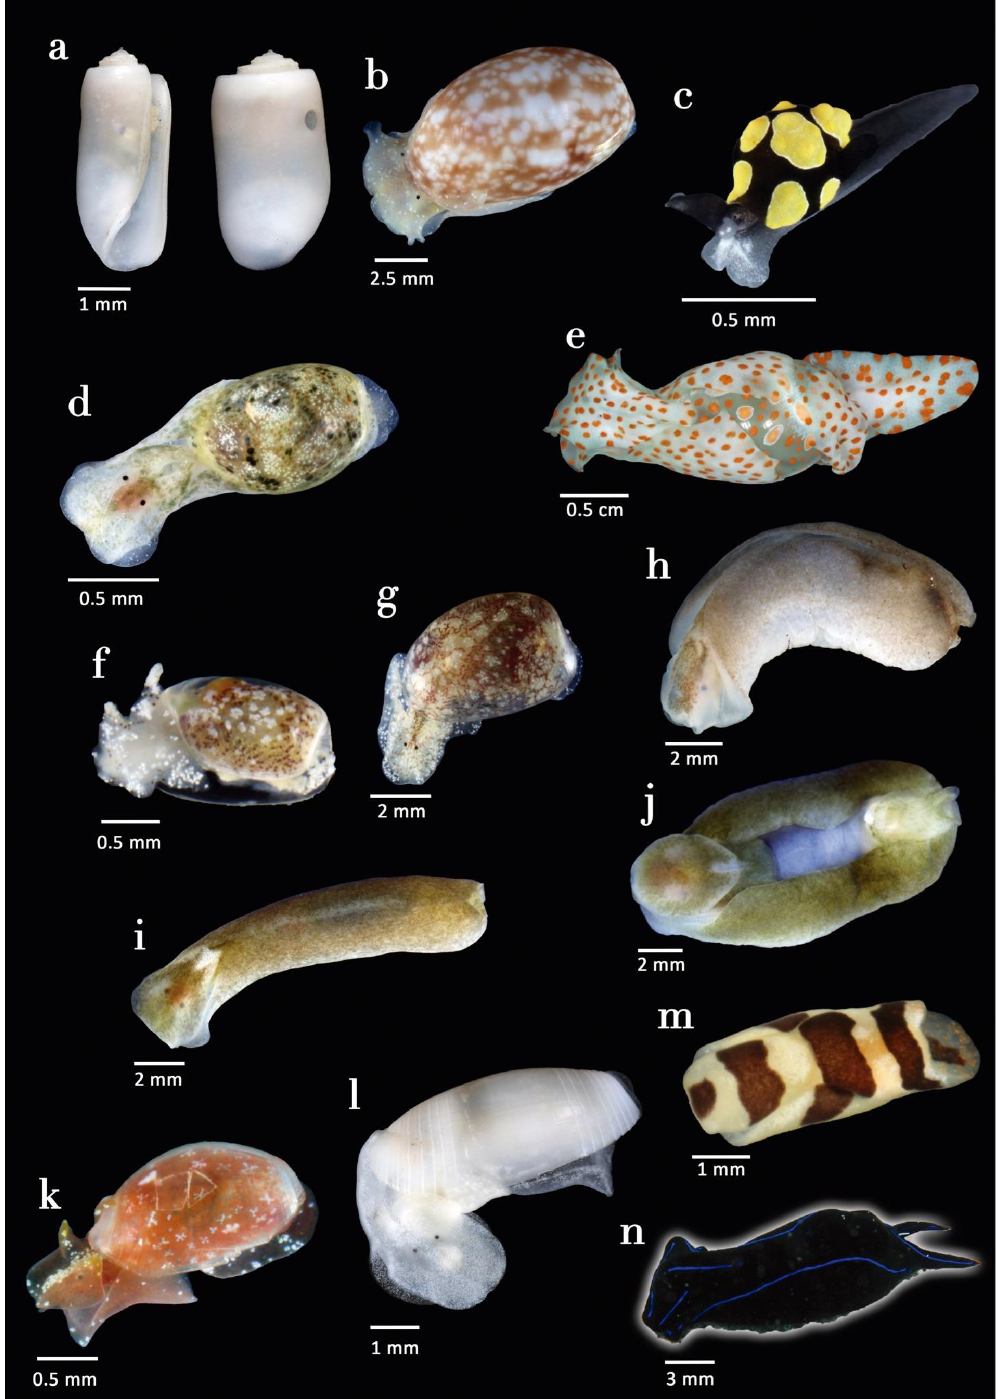
Figure 4. Cephalaspidea: ( a ) Acteocina sp . (MCZ:Mala:393847), dorsal and ventral view; ( b ) Bulla vernicosa (MCZ:Mala:393799); ( c ) Colpodaspis thompsoni (MCZ:Mala:393765); ( d ) Haloa aptei (MCZ:Mala:393843); ( e ) Lamprohaminoea cymbalum (MCZ:Mala:393734); ( f ) ‘Long tail haminoid’ (MCZ:Mala:393732); ( g ) ‘Mini haminoid’ (MCZ:Mala:393728); ( h ) Phanerophthalmus batangas (MCZ:Mala:393707); ( i ) Phanerophthalmus cf. cylindricus (MCZ:Mala:393777); ( j ) Phanerophthalmus minikoiensis (MCZ:Mala:393706); ( k ) Vellicolla muscaria (MCZ:Mala:393871); ( l ) Aliculastrum debile (MCZ:Mala:393820); ( m ) Philine orca (MCZ:Mala:393750); ( n ) Chelidonura varians . Photos by T. J. Cunha; image of ( n ) courtesy of Davide Seveso.